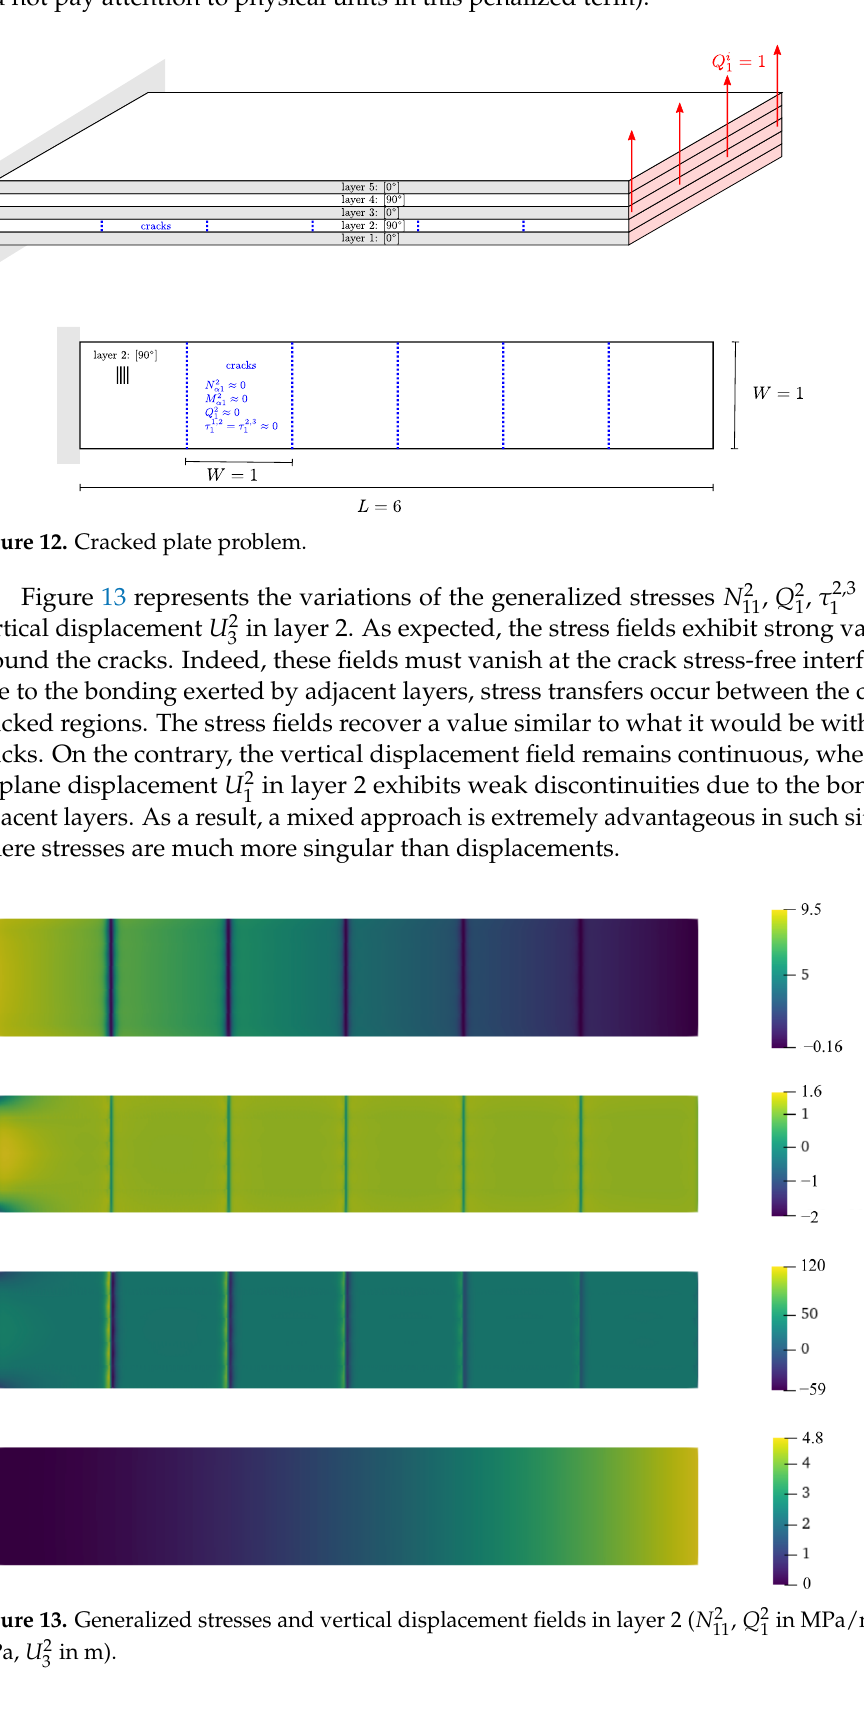
, Q 2 in MPa/m, τ 2,3 11 1